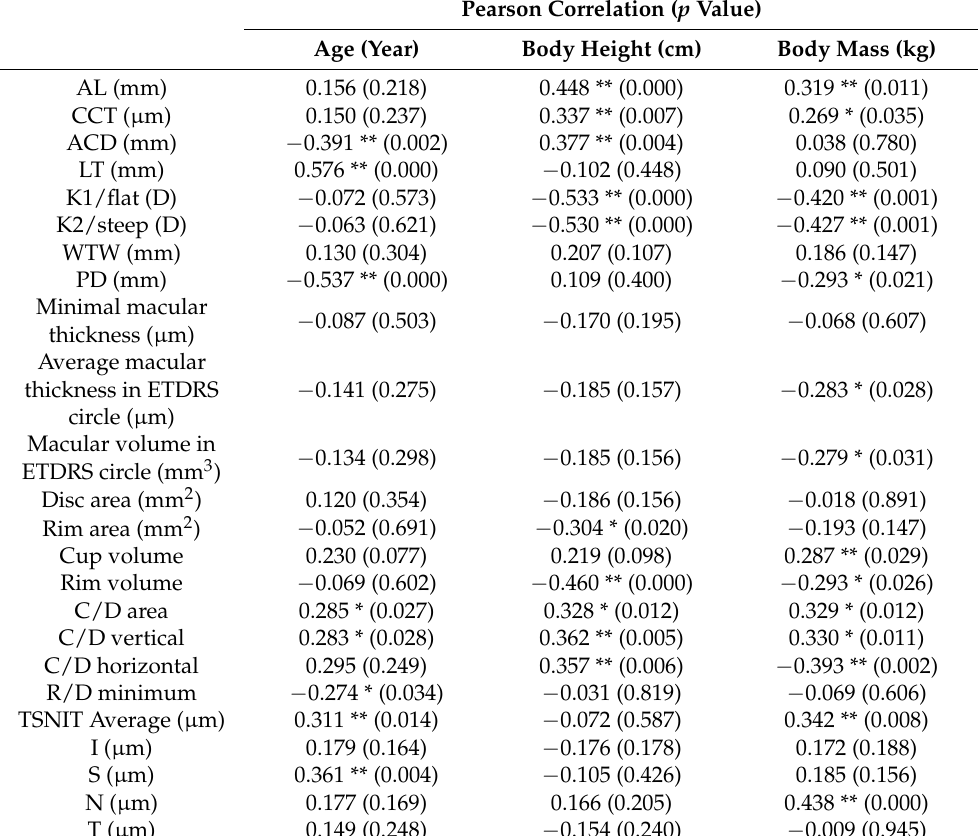
Table 3. The correlations of age, body height and body mass with eye biometric parameters in male (N = 63 eyes)